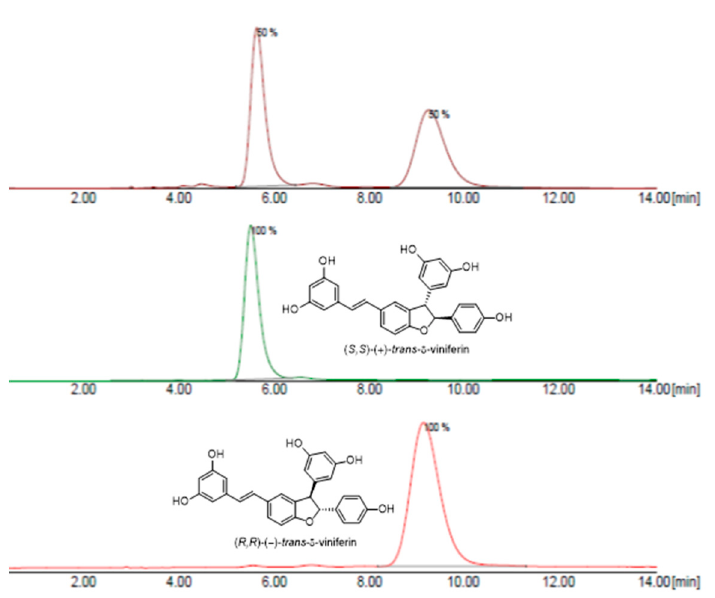
Figure 3. Chromatogram of the separation of two enantiomers of ( ± )- trans - δ -viniferin (( 5 ), top) and ( ± )- trans - ε -viniferin (( 6 ), bottom).